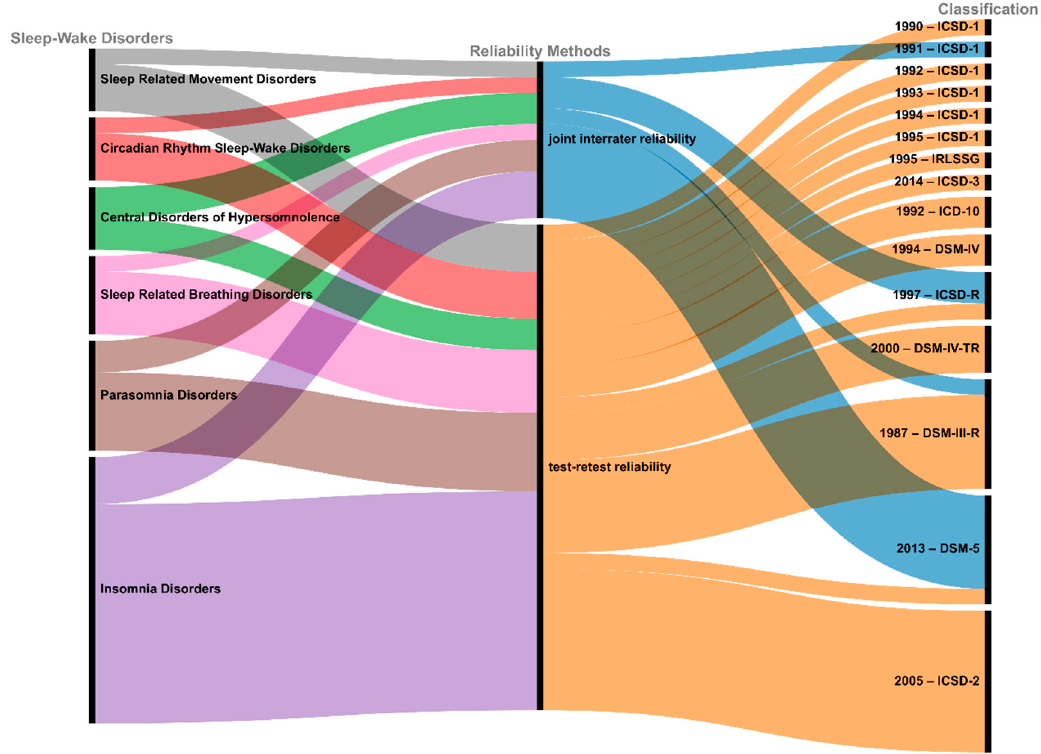
Figure 3. Sankey diagram of sleep–wake disorders, reliability methods, and classifications. The different reliability methods with their associated sleep–wake disorders and classifications are represented via flows. Nodes are represented as black rectangles, and the height represents their value. The width of each curved line is proportional to its values. Each column of a Sankey diagram needs to be read in pairs, i.e., sleep–wake disorders with reliability methods, and reliability methods with classifications. For instance, it is not possible to assert that ICSD-2 is only related to insomnia disorders via the method of test–retest reliability. To analyze the link between classification and sleep–wake disorders, we refer to Figure 2.